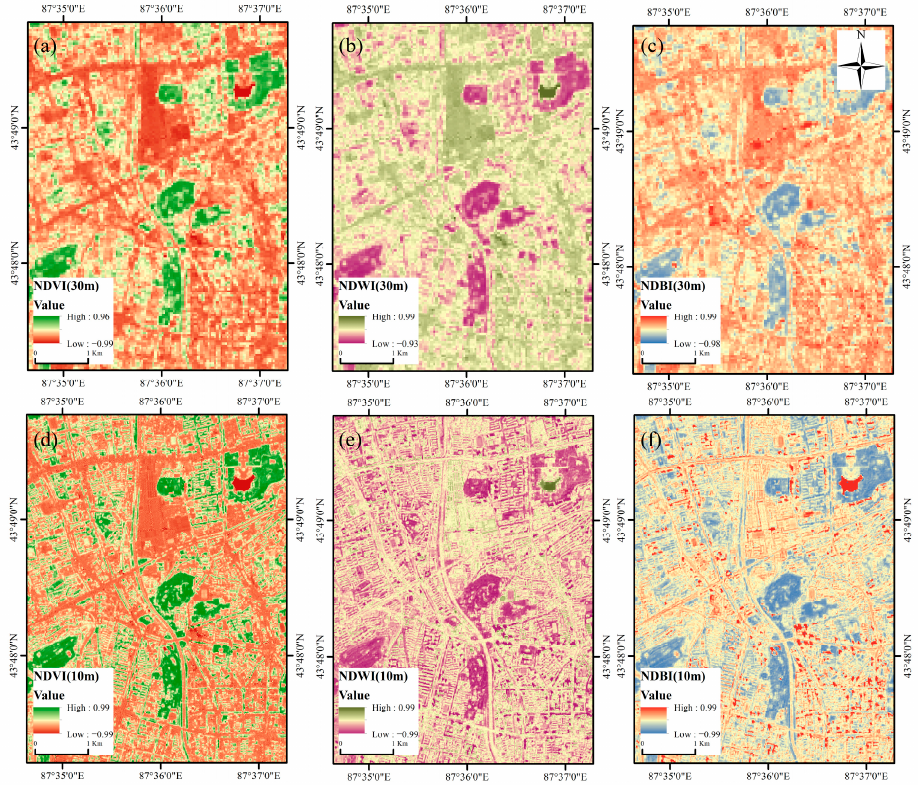
Figure 3. Local comparison of surface parameters: ( a ) NDVI, ( b ) NDWI, and ( c ) NDBI are L8 30 m resolution parameters; ( d ) NDVI, ( e ) NDWI, and ( f ) NDBI are S2 10 m resolution parameters.